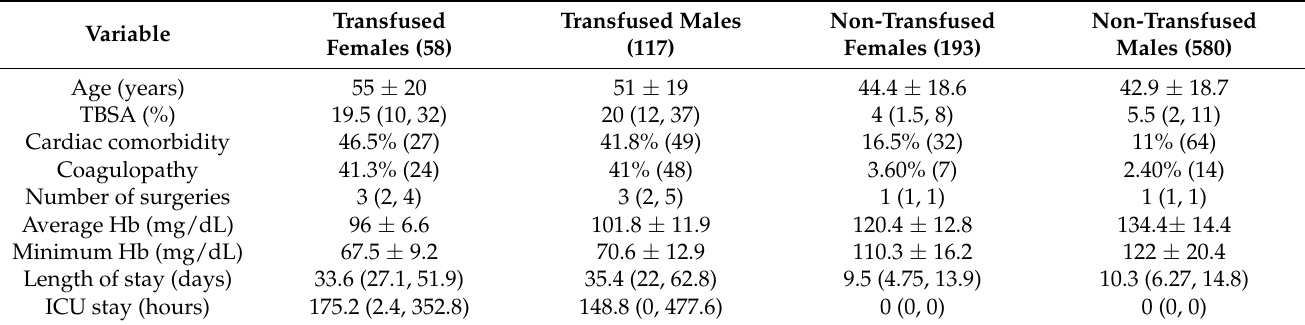
Table 2. Summary of transfused and non-transfused patients by